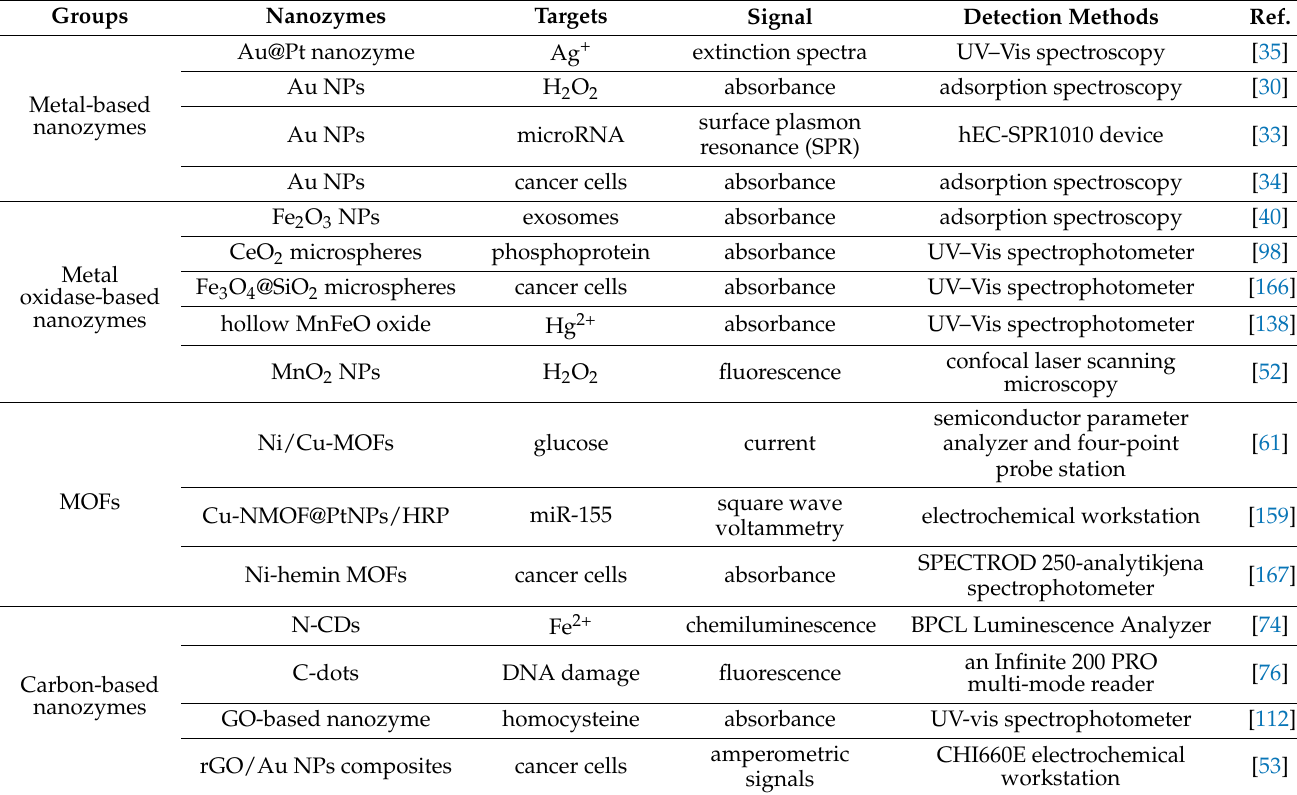
Table 1. Nanozyme classification, major substrates, and detection